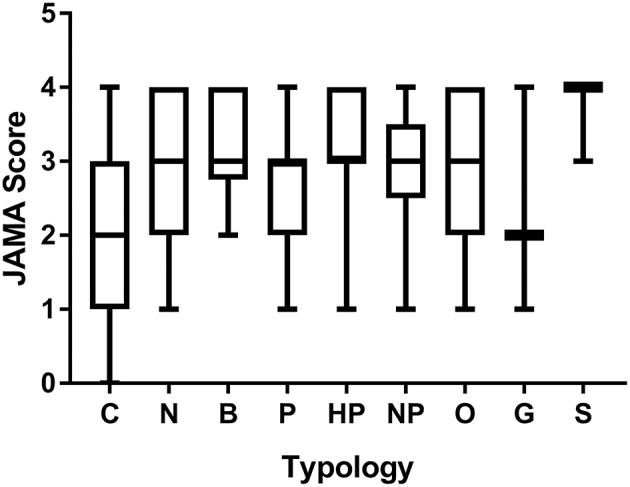
JAMA score of webpages of different typologies. Data are median, IQR, minimum, maximum. Number of webpages for each group was: commercial, 60; News, 59; Blog, 18; Professionals, 16; Health portal, 10; Non-profit organization, 9; Other, 7; Government, 3; Scientific journals, 3.